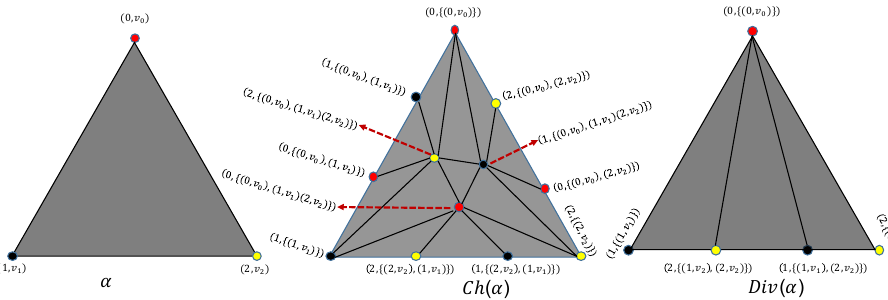
Figure 2. Once standard chromatic and general chromatic subdivision of 2-simplex α